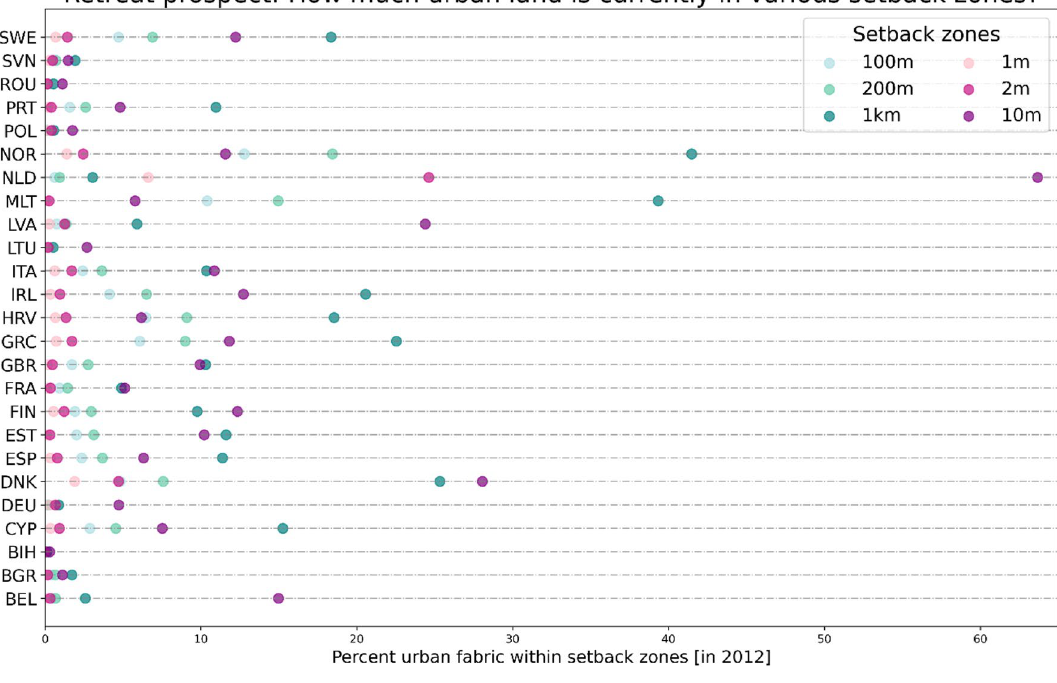
Figure 8. Retreat prospect of EU member states (plus NOR, BIH, GBR): the extent of urban areas that are currently located in different setback zones [using CORINE 2012